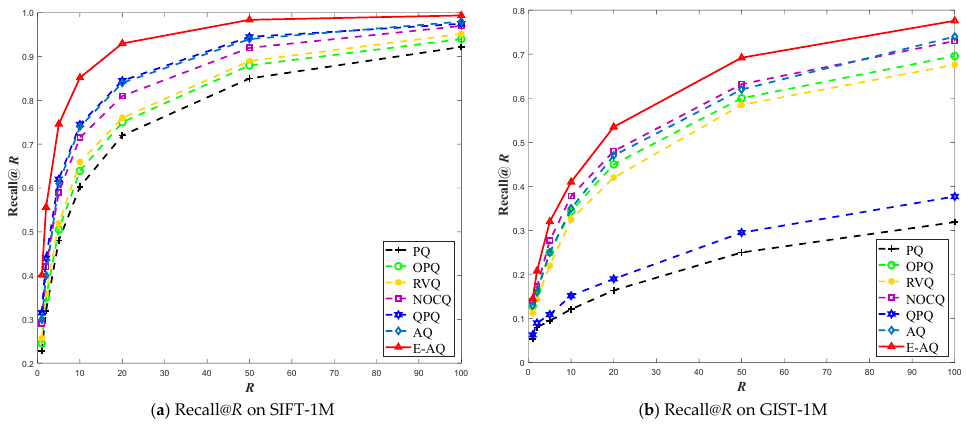
Figure 9. Comparison of exhaustive ANN searches.